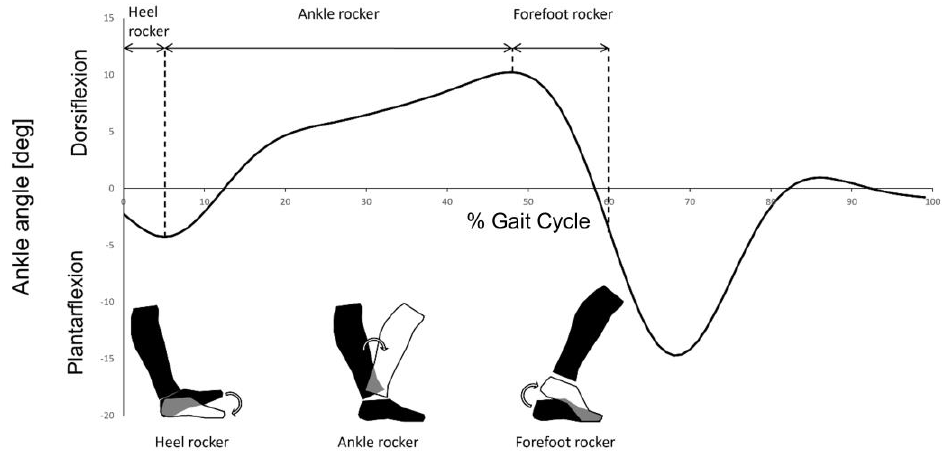
Figure 1. Graphical representation of the heel, ankle, and forefoot rockers within the stance phase (0–60% of the gait cycle). The heel rocker corresponds to the plantarflexion movement of the ankle at the beginning of the stance phase. The ankle rocker corresponds to the dorsiflexion movement during the most part of the stance phase. The forefoot rocker corresponds to the plantarflexion movement at the end of the stance phase.